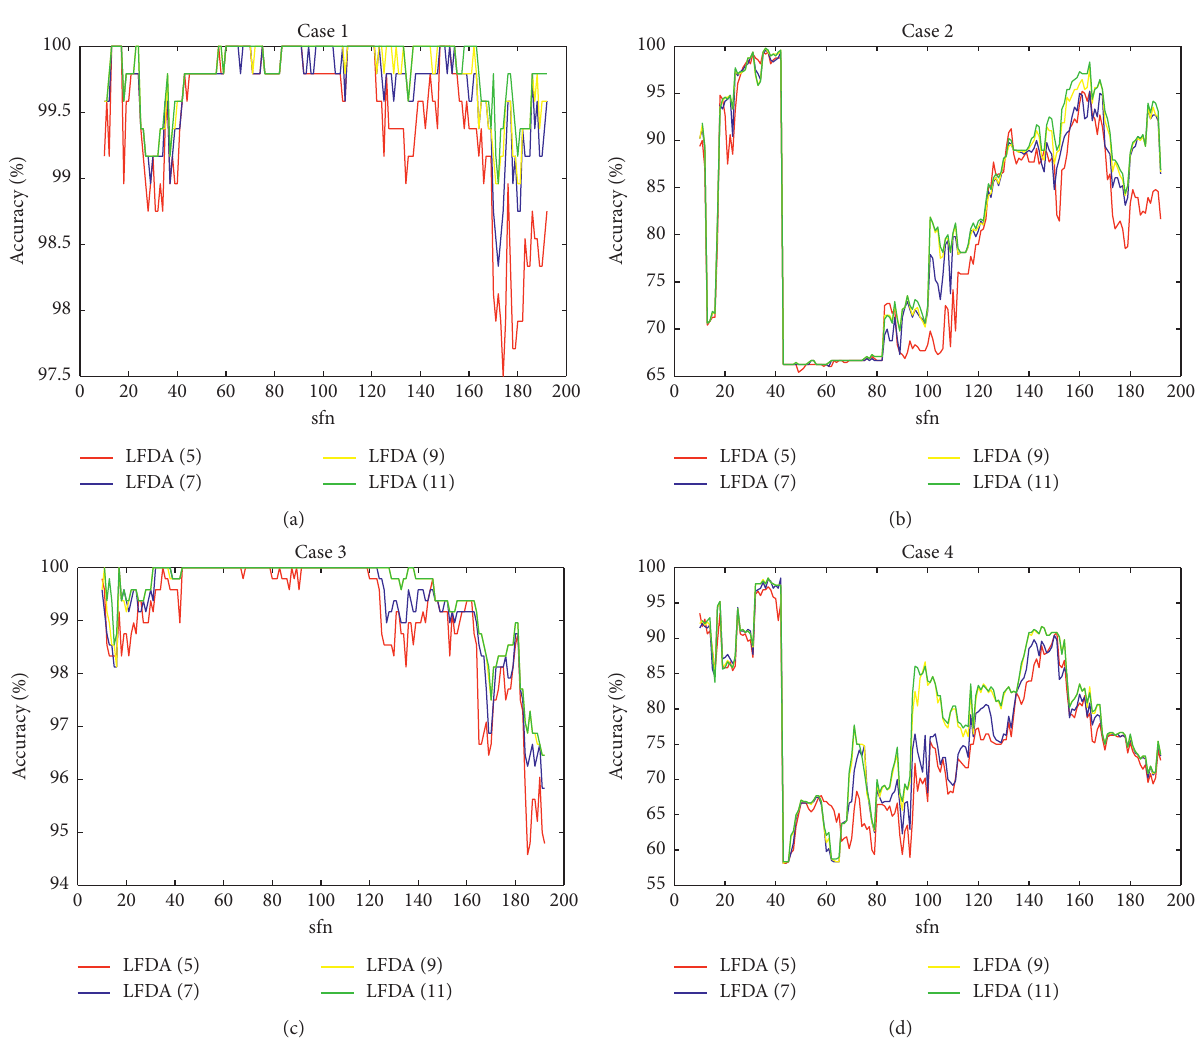
Figure 12: The curve representation of diagnosis results obtained by OFS-TSFRS-LFDA-SVM using DTCWPT with different dimension sizes for LFDA. The LFDA (5) represents that the number of dimension size is